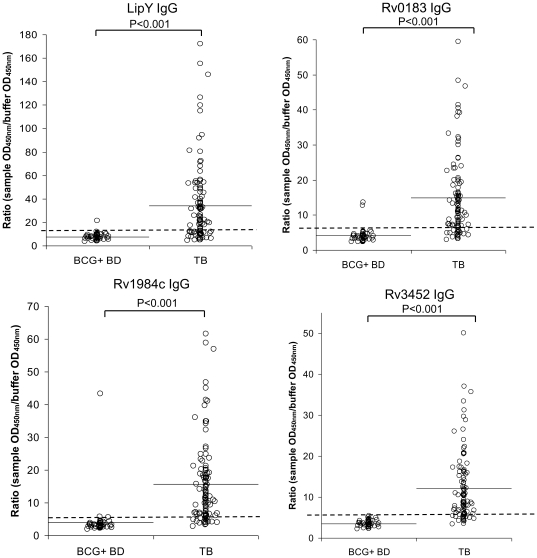
Comparison of the antibody IgG response to recombinant lipolytic enzymes in TB patients and healthy individuals.(A) LipY, (B) Rv0183, (C) Rv1984c and (D) Rv3452. Horizontal lines indicate the mean value, whereas dotted lines indicate the cut-off values, derived from the ROC curves. BCG+ BD, BCG vaccinated blood donors (n = 50), TB, active TB patients (n = 105).